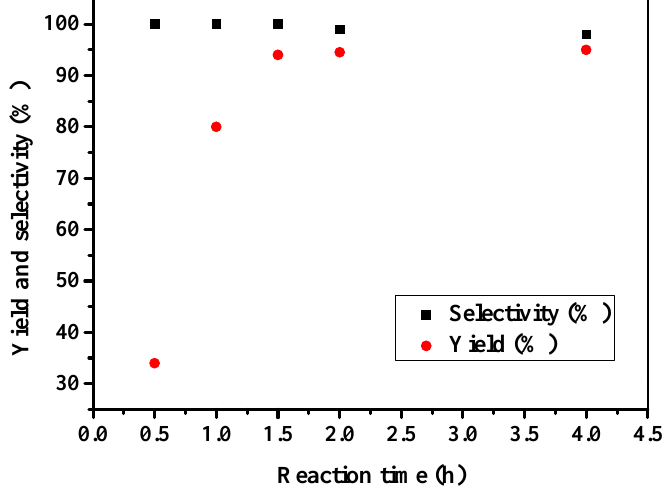
Figure 4. Influence of reaction time on the cycloaddition reaction. Reaction conditions: PO 34.5 mmol, GndCl 1.0 mmol, ZnI 2 0.2 mmol, CO 2 pressure 1.0 MPa, 100